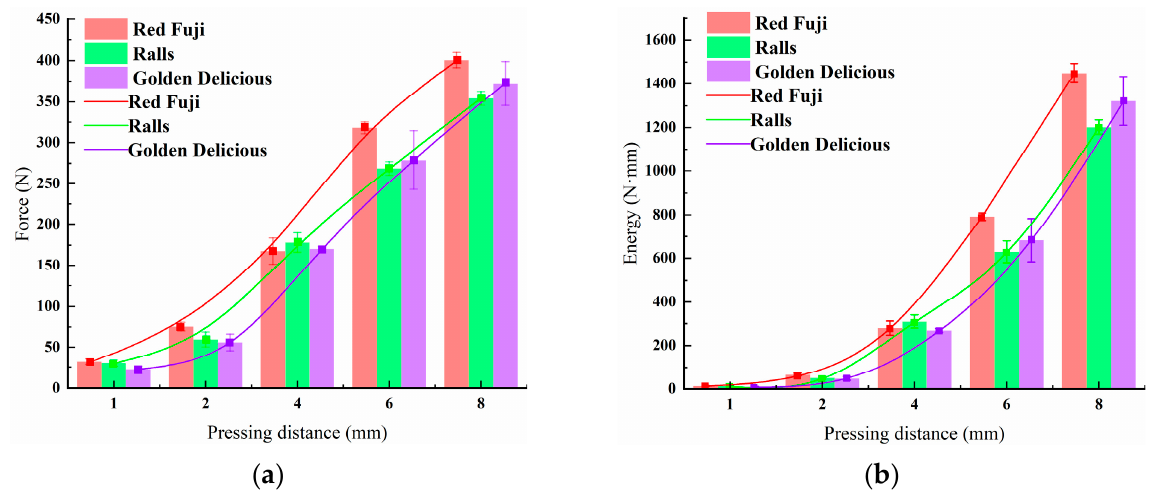
Figure 5. ( a ) Peak force–pressing distance and ( b ) energy–pressing distance fitting curves under a speed of 2 mm/s. Table 2. Peak force–pressing distance and energy–pressing distance fitting parameters for apples.